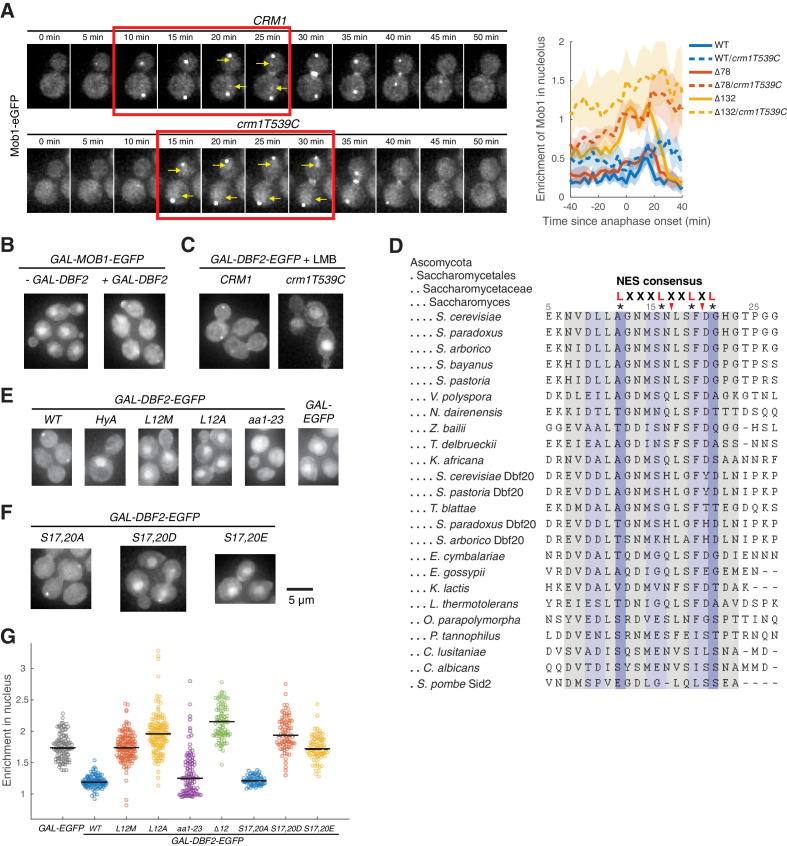
Identification of a functional nuclear export signal (NES) in Dbf2.(A) Mob1’s cellular localization when nuclear export is inhibited. Left, cells (A39893, A41349) were grown at room temperature in SC medium + 2% glucose and leptomycin B (LMB). Red box indicates anaphase and yellow arrows highlight increased nuclear and nucleolar localization. Right, comparison of nucleolar enrichment of Mob1 in CRM1 (A41211, A41212, and A41213; n = 12, 18, and 11 cells respectively) and crm1T539C cells (A41373, A41374, and A41375; n = 13, 9, and 16 cells respectively). Cells were grown at 25°C in SC medium + 2% glucose with 100 ng/ml LMB and imaged every 3 min for 4 hr. (B) Localization of overexpressed Mob1-eGFP from the GAL1-10 promoter with (A41363) or without (A41364) co-overexpressing Dbf2 from the same promoter. Cells were grown in SC medium + 2% raffinose and mounted onto agarose pads made with SC medium + 1% raffinose and 1% galactose. (C) Localization of overexpressed Dbf2-eGFP with (A41383) or without (A41384) inhibiting Crm1 with LMB. Cells were grown in SC medium + 2% raffinose and mounted onto agarose pad made with SC medium + 1% raffinose, 1% galactose, and 100 ng/ml LMB. (D) Alignment of Dbf2 homologs in Saccharomycetes and S. pombe. (E–G) Localization of various Dbf2-eGFP mutants expressed from the GAL1-10 promoter (A41388, A41389, A41386, A41390, A41391, A41392, A41393, A41440, A41441, and A41442; n = 97, 98, 123, 135, 120, 88, 58, 76, and 79 cells respectively). Cells were grown as in (B) and analyzed after 5 hr of growth in galactose containing medium.